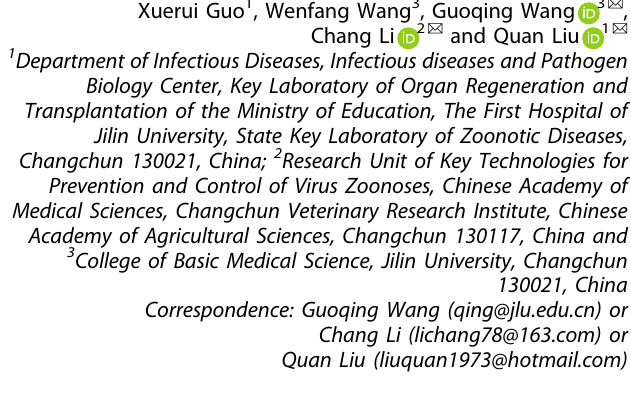
Fig. 1 Transcriptome and proteome reveals host cell cycle checkpoint as antiviral target for SARS-CoV-2. a Log 2 fold change pro fi les of mRNA and protein levels of CDK1 (Cyclin-dependent kinase 1), CDK2 and cyclin B1 in Caco-2 cells infected with SARS-CoV-2. b Caco-2 cells were infected with SARS-CoV-2 at the MOI of 0.01. The cells were collected at 0, 6, 12, 24, and 48hpi and the indicated proteins were analyzed by immunoblots. c Caco-2 cells were mock-infected or infected with SARS-CoV-2 at the MOI of 0.01, 0.1 and 1.0, respectively. After 48 h, cells were harvested and the cell cycle was analyzed by fl ow cytometry. Three independent experiments were conducted, and the data were shown in the column graphs. d Caco-2 cells synchronized to the S phase by 0.85 mM thymidine (Thymi) were mock-infected or infected with SARS-CoV-2 at the MOI of 0.1. After 48 h, cells were collected to analyze the cell cycle by fl ow cytometry. Three independent experiments were conducted, and the data were shown in the column graph. e – g Caco-2 cells were grown in a medium with no serum, 0.85 mM Thymi, or 50ng/ml nocodazole (Noco) to block cells in the G0/G1, G2/M and S phases, the cells were then mock-infected or infected with SARS-CoV-2 at the MOI of 0.1, cells and supernatants were harvested after 30min ( e ) or 48h ( f , g ). The mRNA level of SARS-CoV-2 nucleocapsid (N) was examined by qPCR ( e, f ), and the protein level of SARS-CoV-2 N was analyzed by immunoblot ( g ). h Caco-2 cells were mock-infected or infected with SARS-CoV-2 at the MOI of 0.01. After 48h, the cells were fi xed and stained with indicated antibodies. Red, CDK1 signal; Pink, cyclin B1 signal; Green, SARS-CoV-2 N signal; Blue, DAPI (the nuclear signal). Bar, 10 μ m. i Caco-2 cells were mock-infected, infected with SARS-CoV-2 at the MOI of 0.01, or treated with 50ng/ml nocodazole. After 48h, the cells were harvested and the separated nuclear and cytoplasmic proteins were analyzed for cyclin B1 and CDK1 by immunoblot. j , k Caco-2 cells were infected with SARS-CoV-2 at the MOI of 0.01, cells were collected at 0, 6, 12, 24 and 48 hpi, and the indicated proteins were analyzed by immunoblot ( j ). Gray-scale statistical analysis of AURKA protein was examined by immunoblot using the Image J ( k ). l – n Caco-2 cells were mock- infected or infected with SARS-CoV-2 at the MOI of 0.01 and treated with the indicated concentrations of reversine ( l ), AT9298 ( m ) and MK5108 ( n ), the supernatants were collected at 48 hpi and viral copies was examined using qPCR. o Caco-2 cells were mock-infected or infected with SARS- CoV-2 at the MOI of 0.01 and treated with 2.0 μ M reversine, 10 μ M AT9298, 10 μ M MK5108 or DMSO. The cells were fi xed at 48 hpi and stained for the indicated proteins. Green: SARS-CoV-2 N protein signal; Blue, DAPI (the nuclear signal). Bar, 100 μ